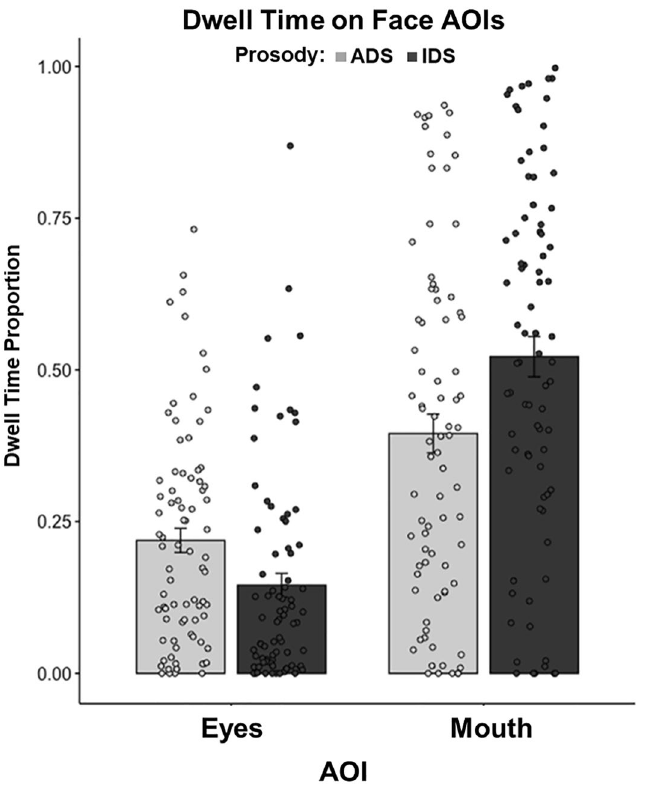
Figure 3. Plot of individual data on the proportion of infant dwell time, compared across AOIs and prosody (adult-directed speech or infant-directed speech). Proportion of looking was calculated by equating the total duration of fixations on the face to 1.00 and determining what proportion of dwell time duration on the face occurred within each AOI. Error bars represent standard error of the